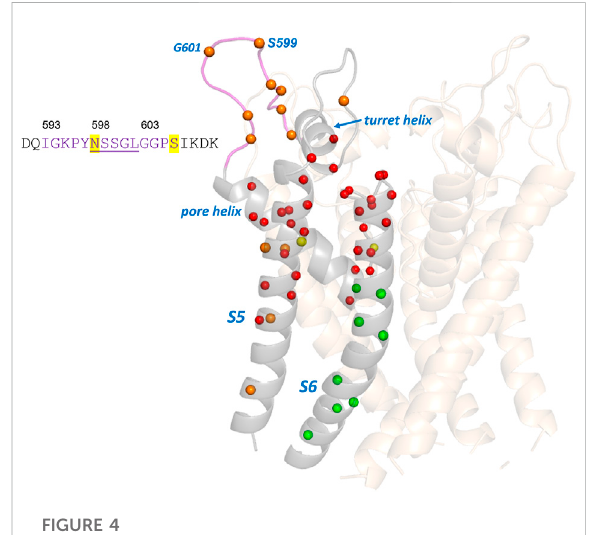
FIGURE 4 Comparison of experimental traf fi cking data for the hERG pore domain with EC analysis. Traf fi cking data is from (Anderson etal.,2014)andECdataforcomparisonisfromTable2.Green and red spheres are matches between EC and traf fi cking data. Green spheres are C α carbons of residues having variants that traf fi c and are absent from the EC data set or, if present, are conservative mutations (Table 2). Red spheres denote variants that mistraf fi c and are present in the EC set. Orange (poor traf fi ckers absent from EC set) and yellow spheres (moderate to good traf fi ckers present in the EC set with lower conservation scores) are mismatches between EC data and traf fi cking data. The sequence of the turret loop highlights the hERG glycosylation site (N598) and a phosphorylation site (S606). Underlined amino acids are residues lacking atom density in the cryoEM structures of hERG; these residues are modeled into the structure